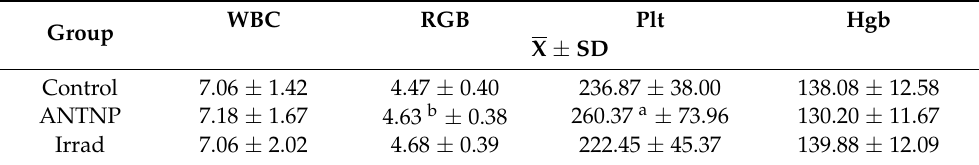
Table 2. The impact of occupational exposure on complete blood count. WBC Group